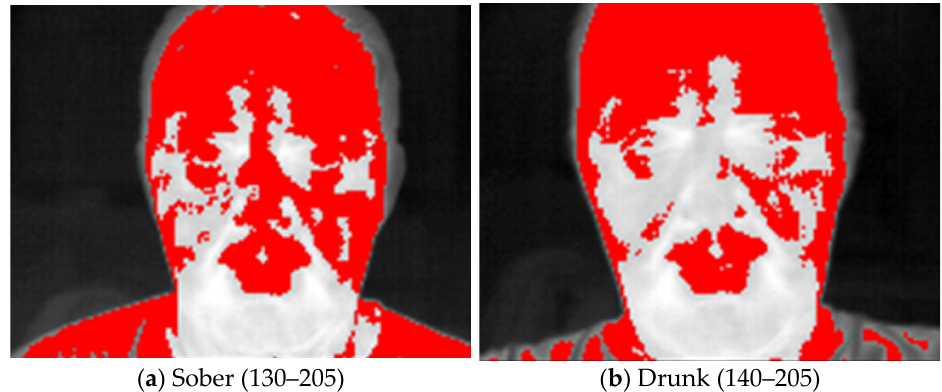
Figure 5. ( a ) For the sober person the forehead lies in the same isothermal region together with other locations of the face. ( b ) The forehead lies in a different isothermal region than the rest of the face for the drunk person.